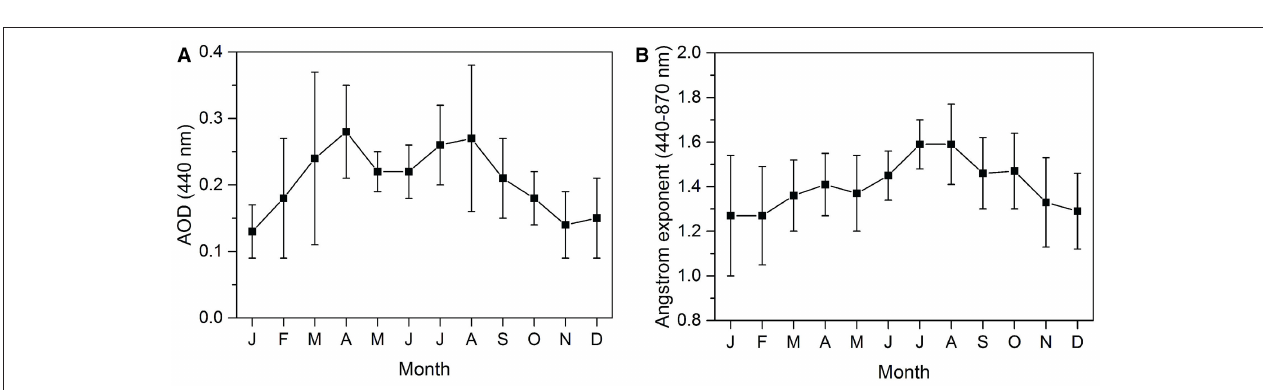
FIGURE 5 | Seasonal changes (A) of the AOD and (B) Ångström exponent over Kyiv site. Data level 2.0 averaged over 2008–2016.